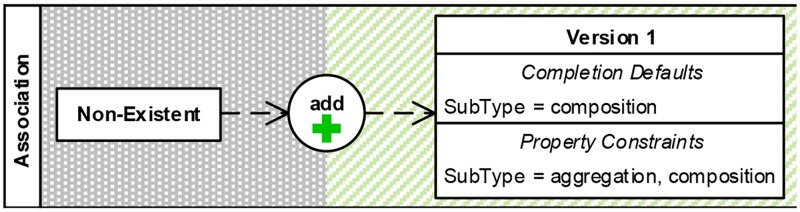
Visual representation: Completion defaults (C7).